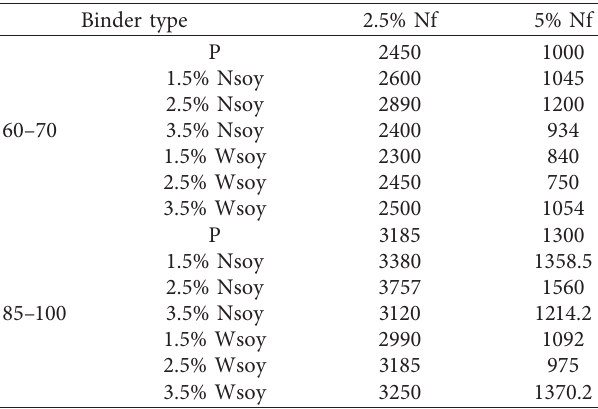
Table 9: Fatigue lives of unmodified and modified binders. Binder type